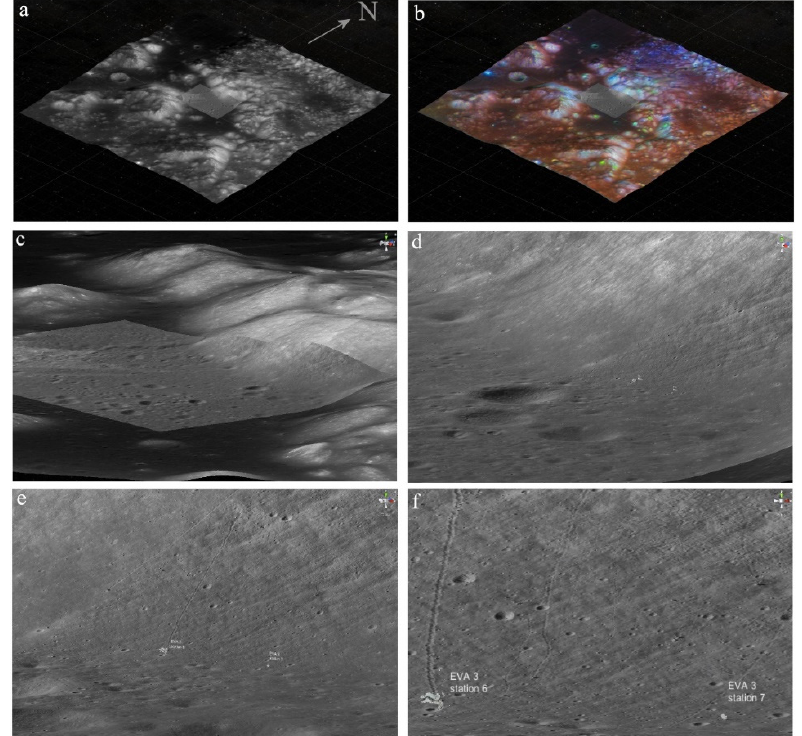
Figure 2. ( a ) Perspective view of a Kaguya-TC mosaic draped over a LOLA-Kaguya TC merged digital elevation model, providing the context of the Taurus-Littrow valley (north is pointing on the upper right corner, and the tile dimension is 55 × 55 km). The Lunar Reconnaissance Orbiter NAC 50 cm mosaic appears in a lighter shade in the center of the frame. ( b ) Clementine UVVIS Color ratio composite draped over the same DEM. ( c )–( f ) display progressive close-up views showing the location of the reconstructed boulders at Station 6 and 7 at the foot of North Massif that is discussed in Section 3. The distance between Station 6 and 7 is 490 m.